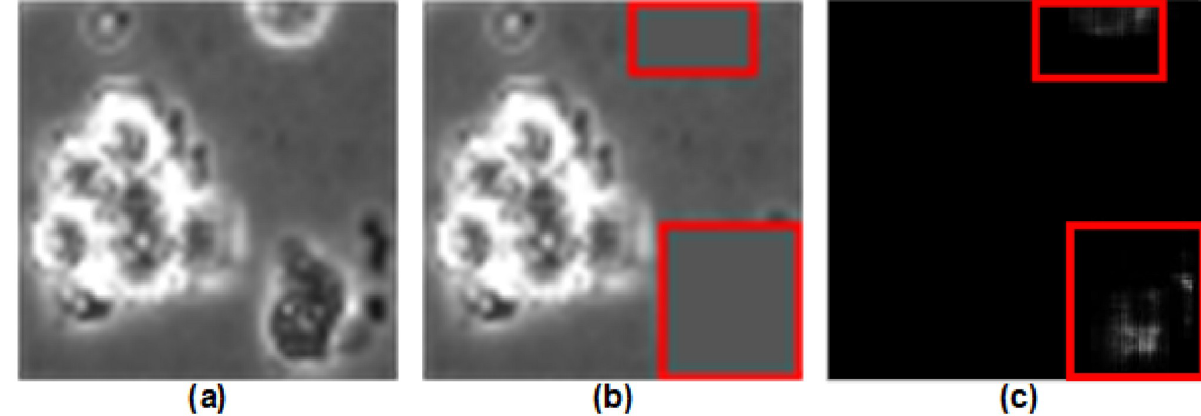
Fig 12. Visualization of features learned by DeephESC 2.0. (a) Image of a Cell cluster . (b) Image after masking the surrounding small cells using a window. Red bounding boxes are drawn across the masked area only for visualization purposes. (c) Probability heat map for the class Apoptically Blebbing cell